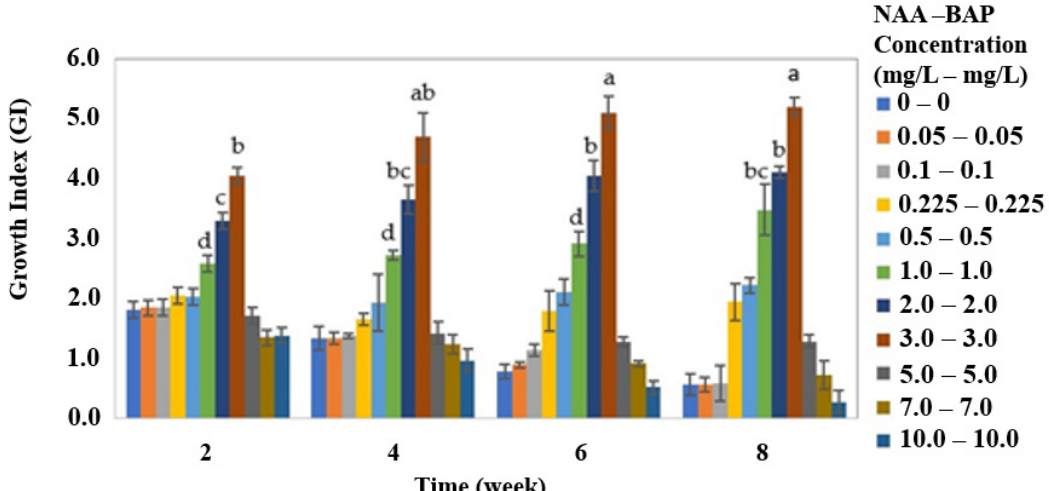
Figure 3. Growth index (GI) for callus culture of T. officinale derived from hypocotyls for different PGR concentrations (0 to 10.0 mg/L of NAA and BAP each, in combination) at every subculturing (medium MS supplemented with 2.3% sucrose, 18 ± 2 °C, 0/24 h light/dark, 2-month subculturing). Letters indicate significance at p < 0.05.